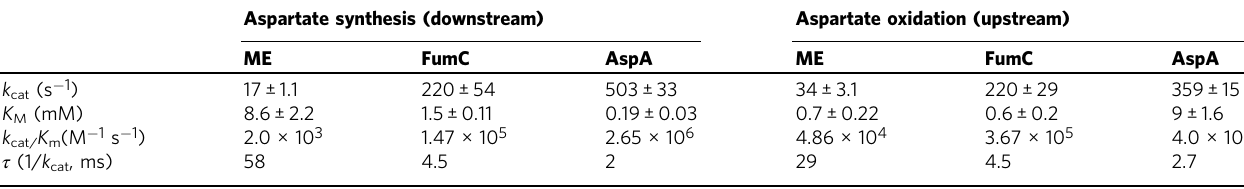
Numbers refer to mean values ( N = 3 independent replicates) followed by standard